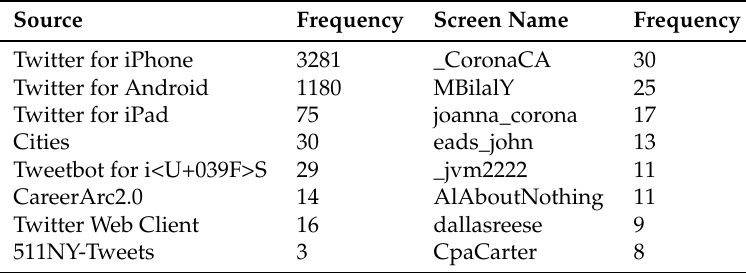
Table 3. Summary of exogenous